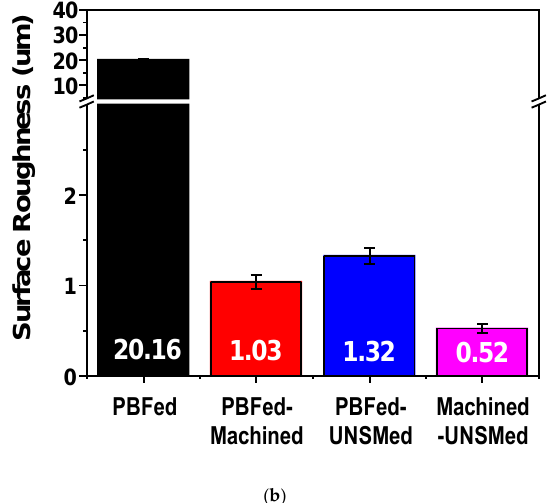
Figure 10. Comparison of ( a ) treated surface of each sample and ( b ) surface roughness for different post-processing approaches.